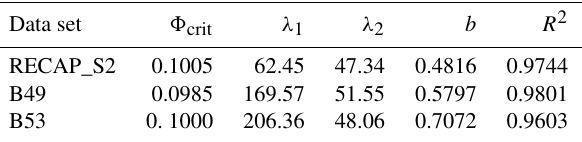
Table 2. Results of least squares fitting our parametrization to the obtained